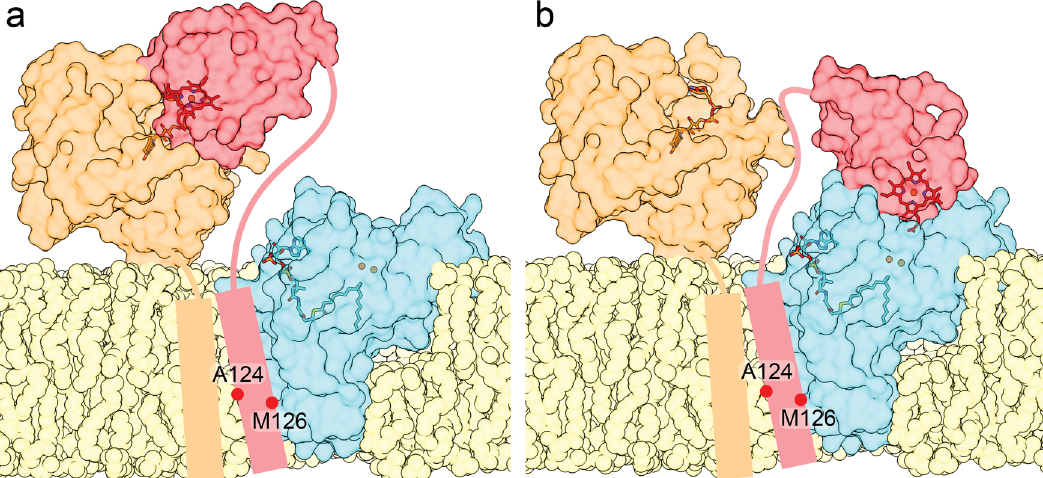
Fig. 7 Model of the stable SCD1-cyt b5-b5R complex. SCD1 (cyan), cyt b 5 (red), and b 5 R (orange) are shown as translucent surfaces highlighting the diiron center (orange sphere) and acyl-CoA (cyan stick) in SCD1, heme (deep red stick) in cyt b 5 , and FAD (brown stick) in b 5 R. SCD1 forms a complex with the TM helix of cyt b 5 and b 5 R in lipid bilayer (yellow). The relative positions of two residues on the TM helix of cyt b 5 are marked. A fl exible linker connecting the soluble domain of cyt b 5 and b 5 R to their TM helix allows the transition of two states: a cyt b 5 receiving an electron from b 5 R; and b cyt b 5 delivering an electron to